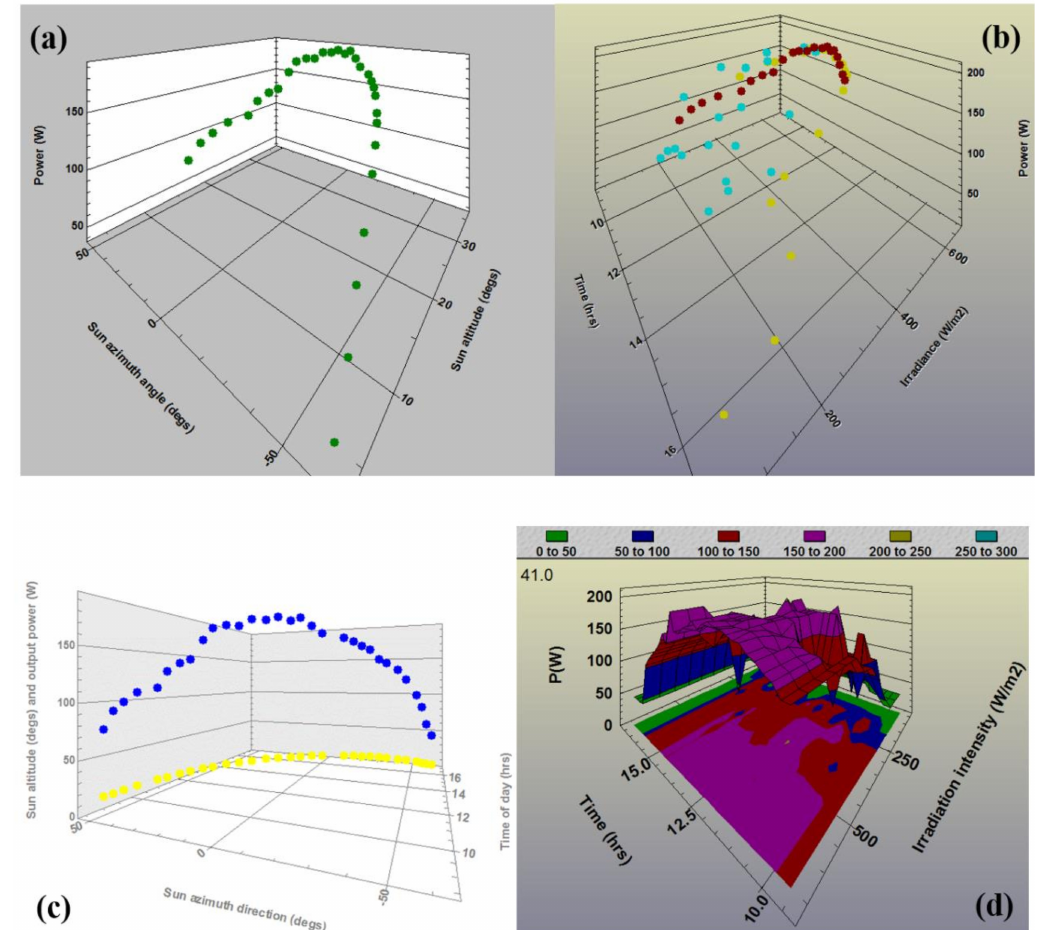
Figure 6. Electric output power trends observed with respect to the solar geometry and irradiation-related parameters. ( a ) 3D scatter plot of the output power vs the Sun azimuth and Sun altitude angles; ( b ) 3D scatter plot of the output power vs the time of day and the horizontal-plane solar irradiation intensity; ( c ) 3D scatter plot of the output power shown in correlation with the Sun altitude angle, vs the Sun azimuth direction and the time of day; ( d ) 3D surface plot (and its corresponding 2D contour plot shown in the X-Y plane underneath) illustrating the variations in the electric output power with both the time of day, and the instantaneous weather-dependent (horizontal-plane) solar irradiation intensity. The data were collected over the entire period of study (about 2 months) covering a wide range of weather conditions observed at regular intervals at most times of